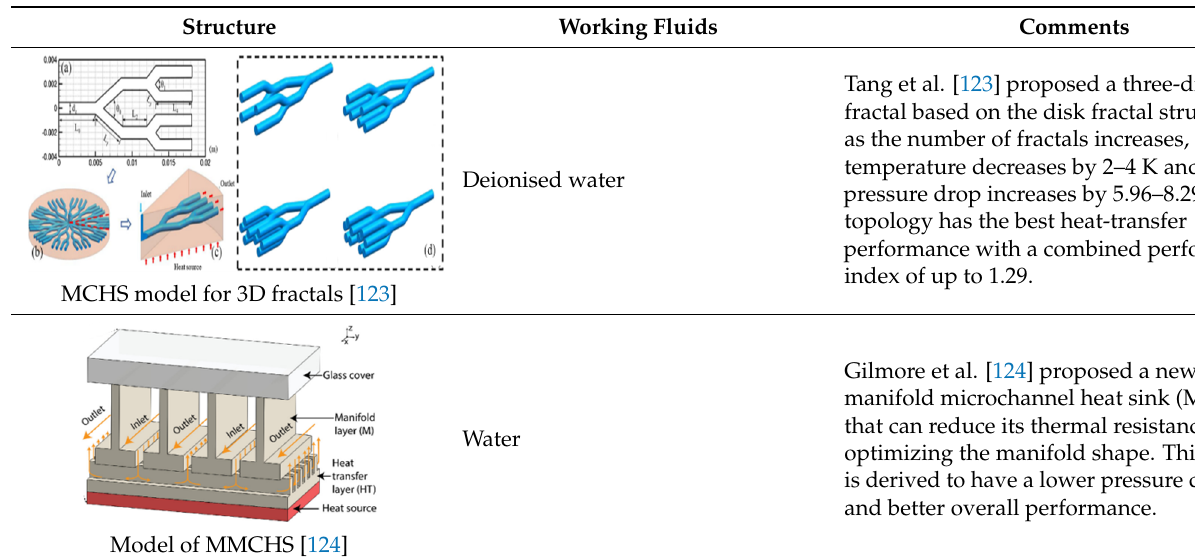
Table 7. Flow and heat-transfer performance of different MCHS structures using nanofluids.